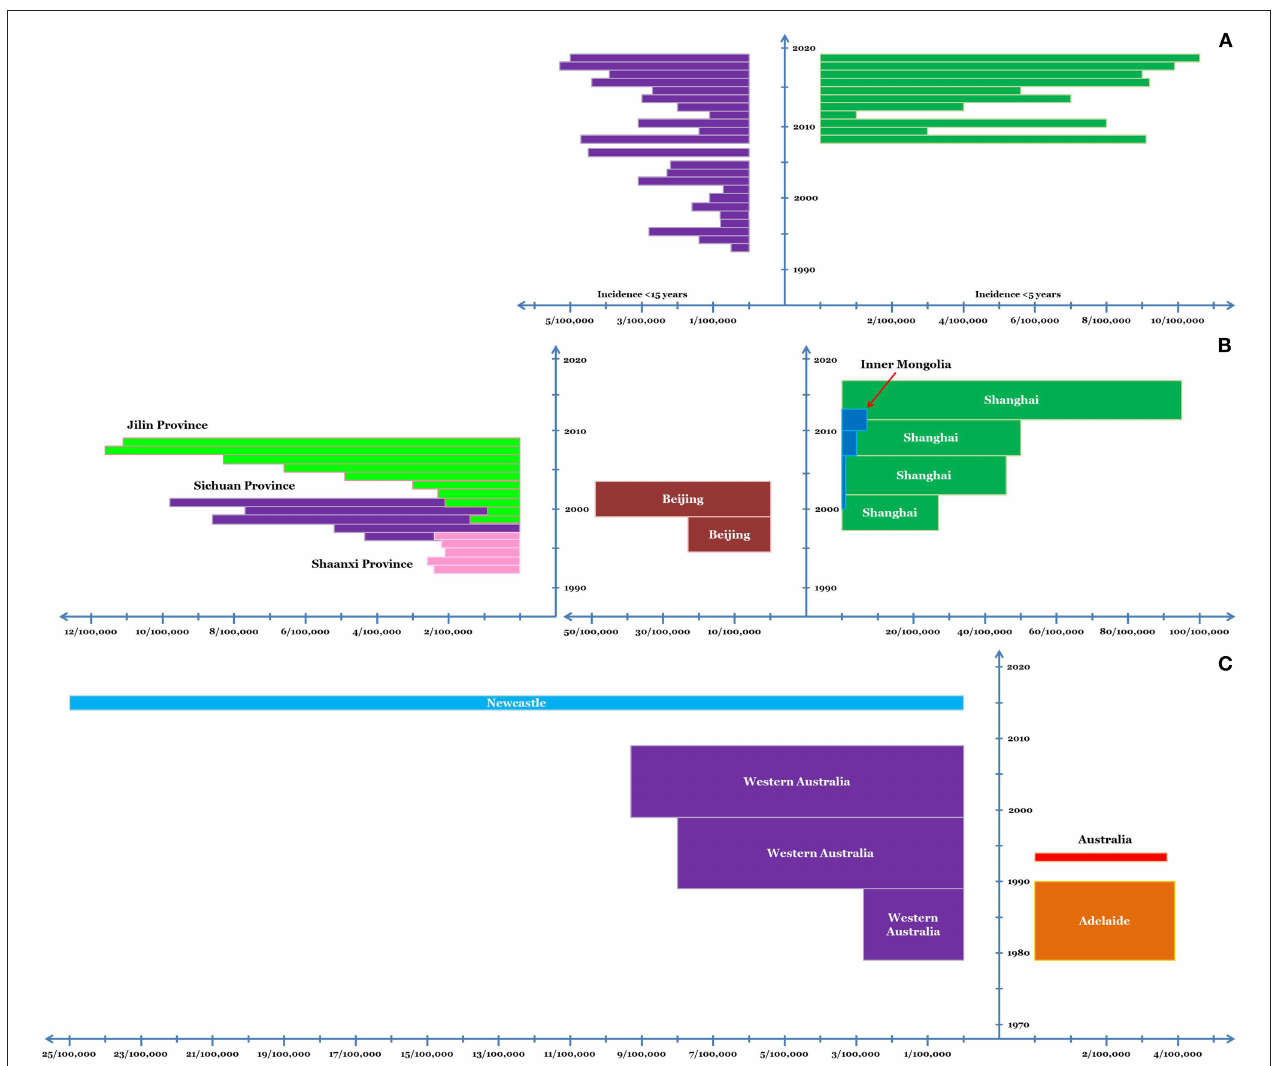
FIGURE 2 | Incidence of KD in Chandigarh, India, (A) and various regions of China (B) and Australia (C) . In case of Chandigarh, India, the incidence in children < 5 and < 15 years of age is shown; while for China and Australia, incidence in young children is depicted. The x-axis depicts the incidence and the y-axis depicts the timeline. The dimension of the bars along the x-axis (length of the bars) depicts the average annual incidence of KD. The dimension of the bars along the y-axis (width of the bars) corresponds to the duration for which the said average annual incidence was